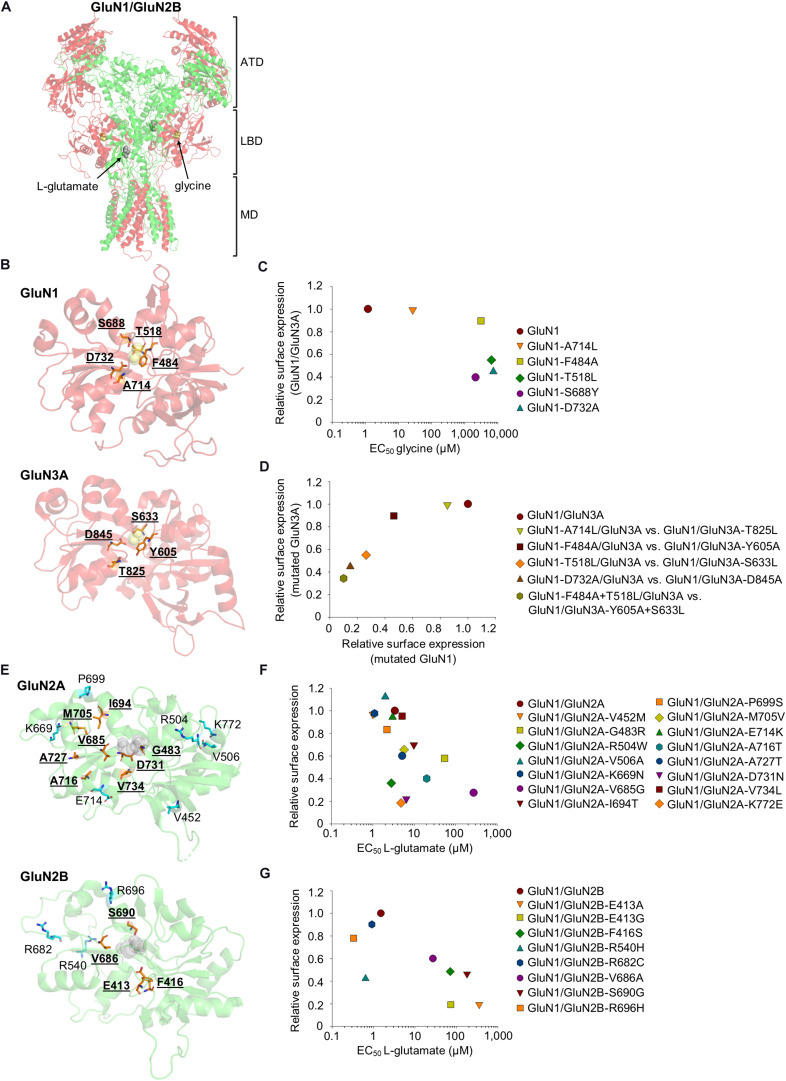
(A) The crystal structure of the GluN1/GluN2B heterotetramer (PDB code: 5IOU) (Zhu et al., 2016), including the glycine (yellow) and L-glutamate (gray) molecules. ATD, amino-terminal domain; LBD, ligand-binding domain; MD, membrane domain (the C-terminal domain is not shown). The GluN1 is shown in red, and the GluN2B is shown in green. (B,E) Schematic depiction of the LBD in the GluN1 (PDB code: 1PB7), GluN3A (PDB code: 2RC7), GluN2A (PDB code: 5H8Q), and GluN2B (PDB code: 5IOU), including the glycine [yellow, (B)] and L-glutamate [gray, (E)] molecules. The amino acid residues reviewed in the text are indicated, and residues included in the published series of mutant NMDARs with altered EC50 values for glycine/L-glutamate and surface expression are shown in orange. (C) The relationship of surface expression of mutated GluN1 co-expressed with wild-type GluN3A (Skrenkova et al., 2019), the EC50 values for glycine were obtained using GluN1/GluN2A receptors (Williams et al., 1996; Kvist et al., 2013; Skrenkova et al., 2020). (D) The relationship of surface expression of GluN1/GluN3A receptors with analogous mutations in GluN1 and GluN3A (Skrenkova et al., 2019). (F,G) The relationship of surface expression of the indicated GluN1/GluN2A (F) or GluN1/GluN2B (G) receptors with their EC50 values for L-glutamate (Laube et al., 1997; She et al., 2012; Swanger et al., 2016). If necessary, the values of the relative surface expression of NMDARs were obtained by calculating values from graphs from the publications using ImageJ 1.52N software (National Institutes of Health, Bethesda, Maryland, United States) (Schneider et al., 2012).